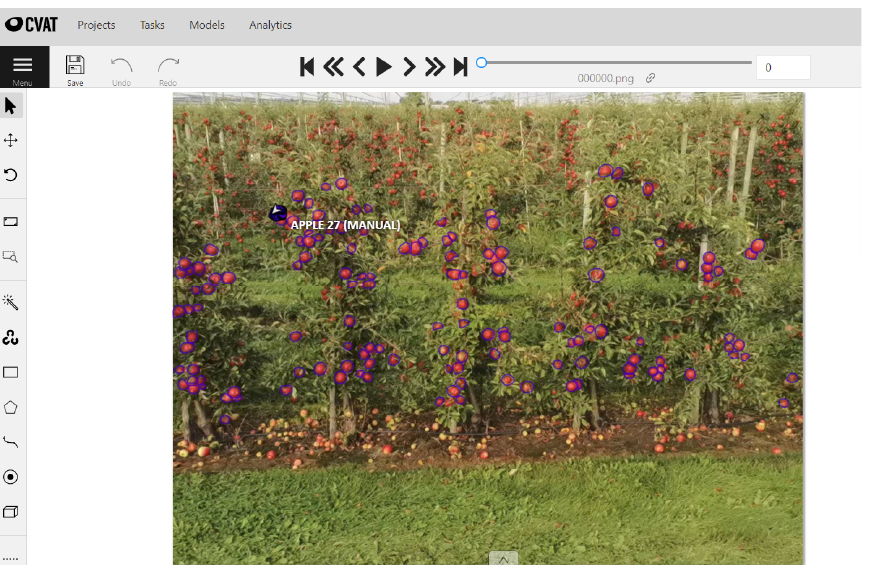
Figure 3. Image markup in CVAT.